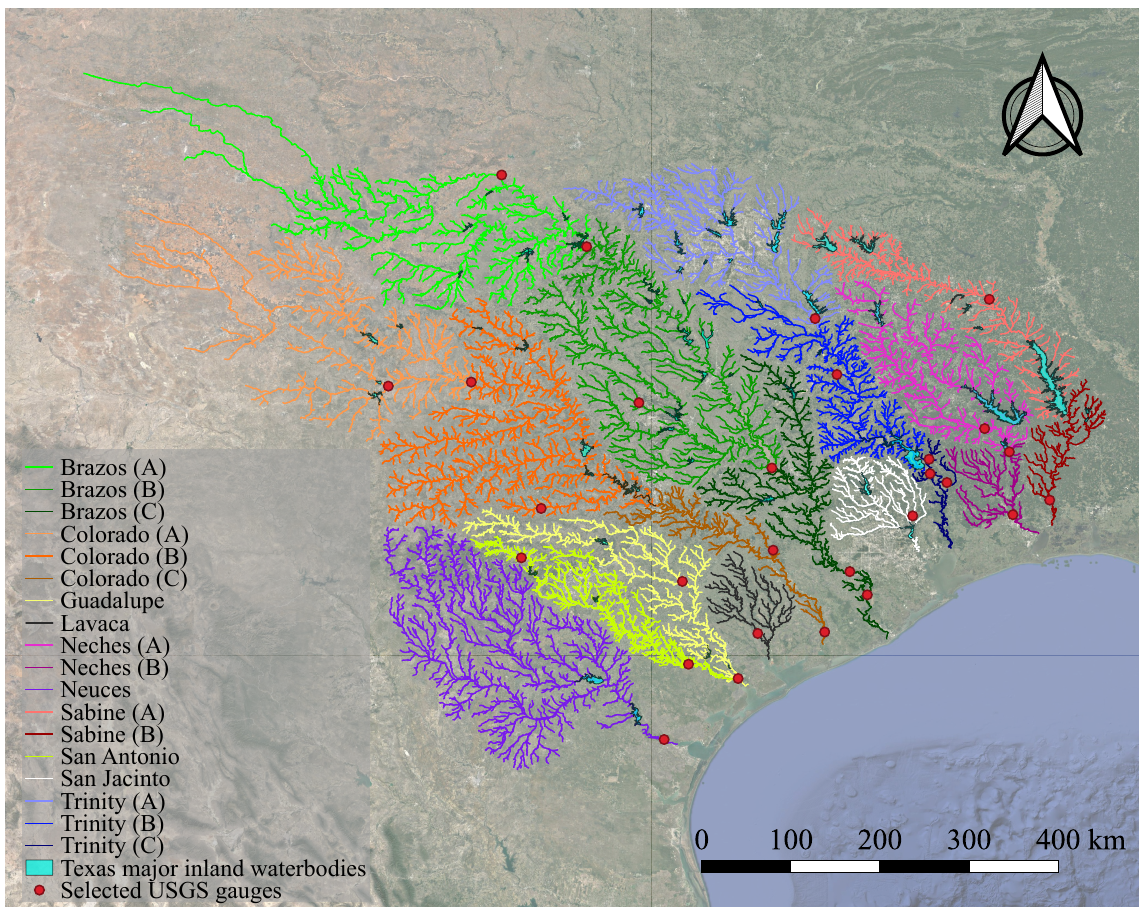
Figure 5. Spatial distribution of 18 subdivided networks from 10 major river systems in Texas–Gulf region. The 30 selected USGS gauges for determining the flow condition in the test case are also